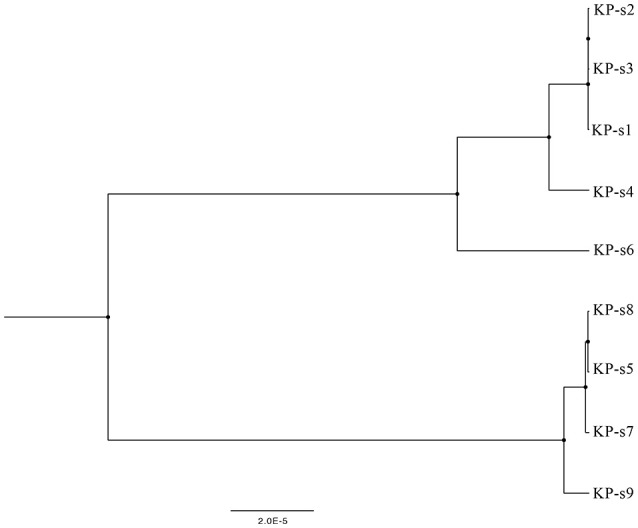
Phylogenetic tree of CP-Kp outbreak isolates based on whole-genome sequencing. The upper branch includes KP-s1, s2, s3, s4, and s6, KP-s5, s7, s8, and s9 are in the lower branch.